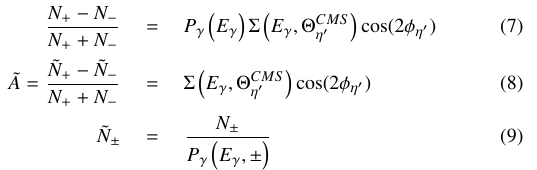
Figure 4. Spectrum of the missing mass to the forward going proton.